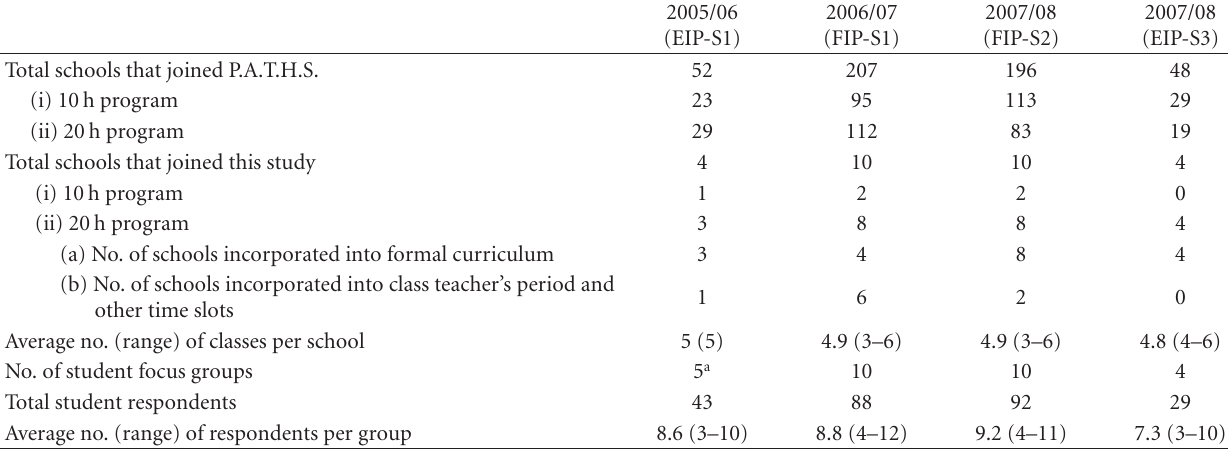
Table 1: Description of data characteristics from 2005 to 2009.